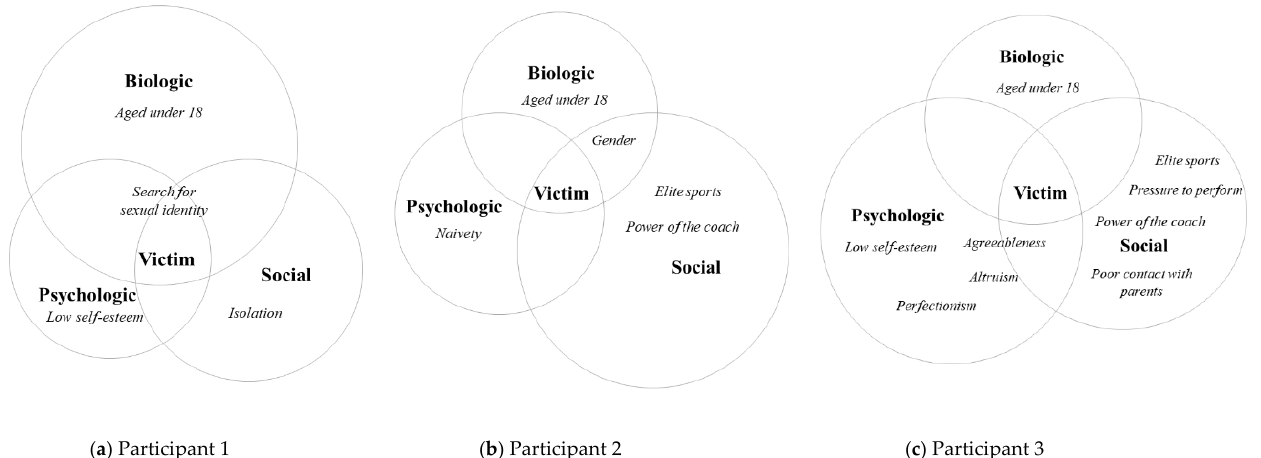
Figure 3. Schematic overview of three biopsychosocial profiles.